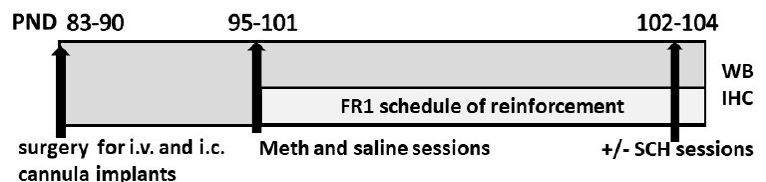
Figure 1. Schematic of experimental design indicating postnatal day of the rats, surgery for cannula implants, self-administration sessions, and euthanasia. Postnatal days (PND), intravenous (i.v.), intracranial (i.c.), methamphetamine (Meth), SCH23390 (SCH), Western blotting (WB), immunohistochemistry (IHC).